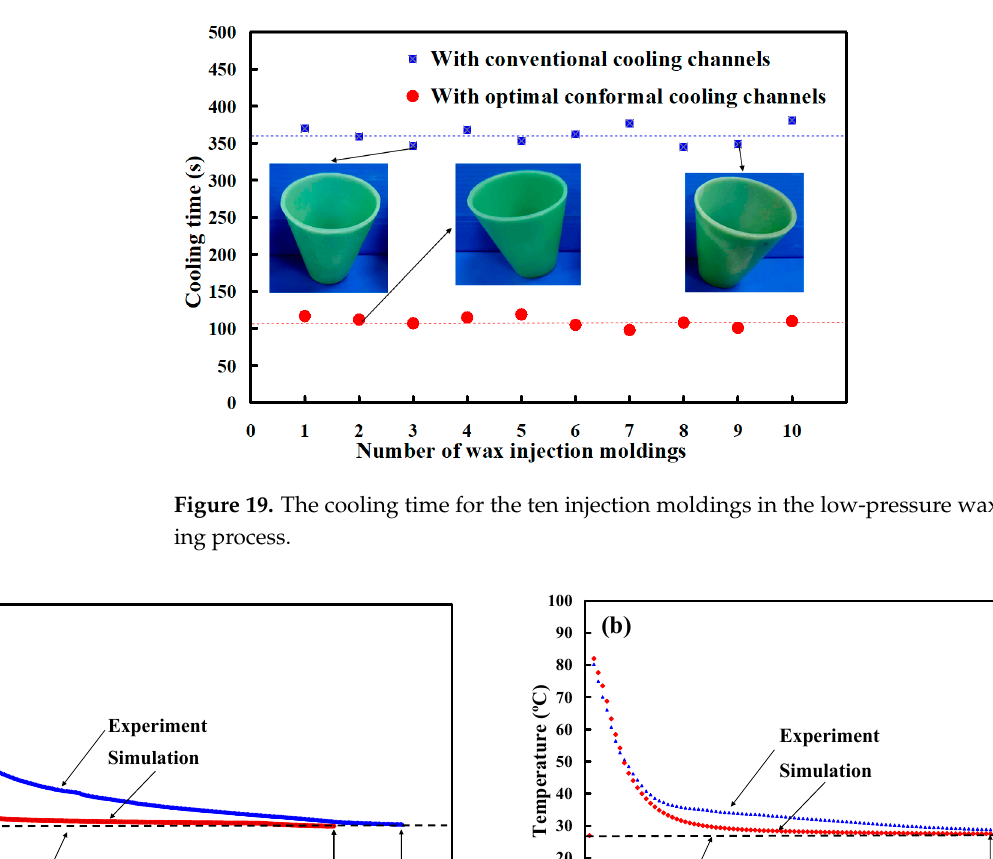
Figure 18. A innovative method for fabricating a large intermediary mold for large a wax injection mold.